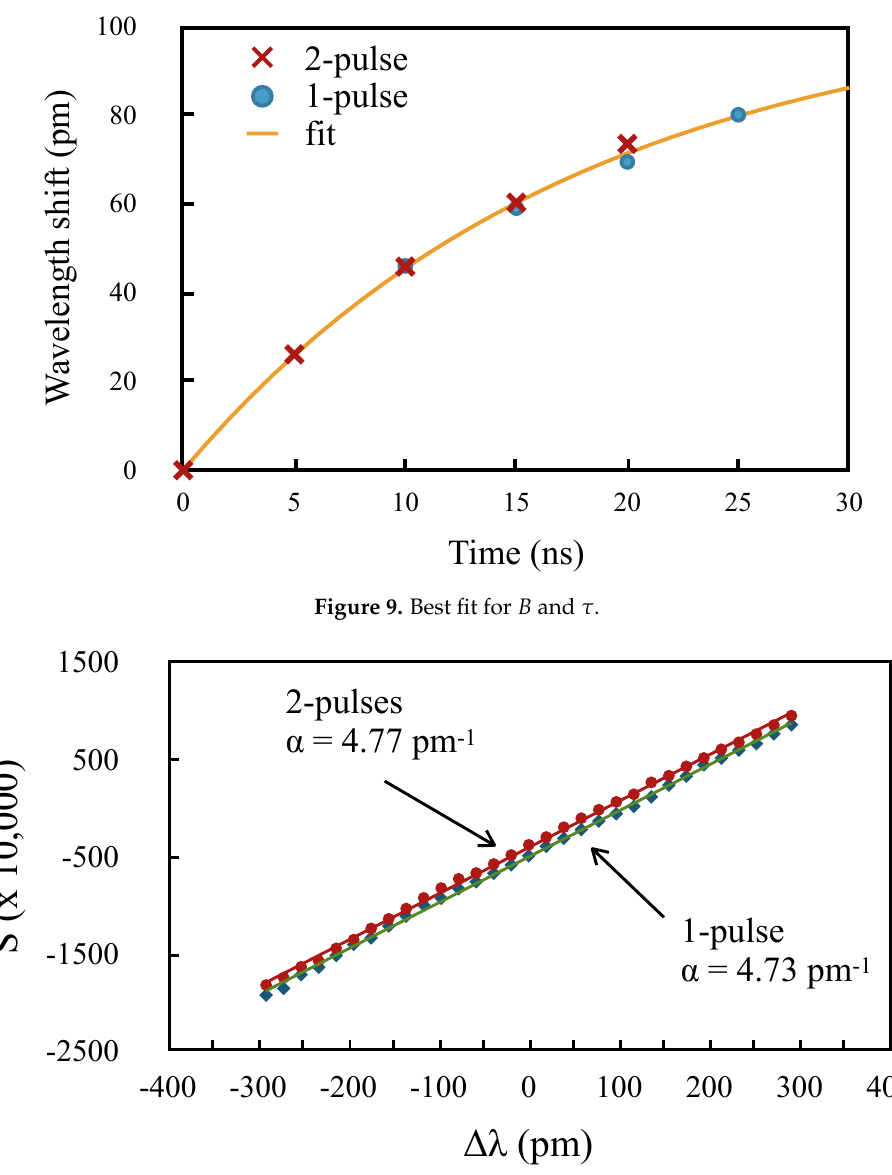
Figure 10. S vs. ∆ λ for both schemes, for 15 ns delay between samples in the one-pulse